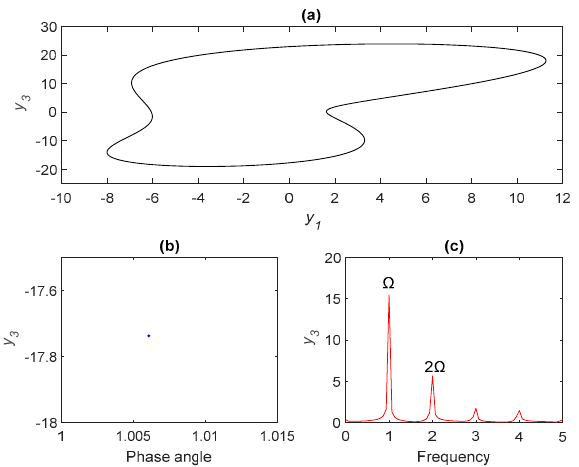
Figure 2. Period-1 orbit for σ = 4.05: ( a ) phase portraits, ( b ) Poincare maps, and ( c ) frequency spectra.